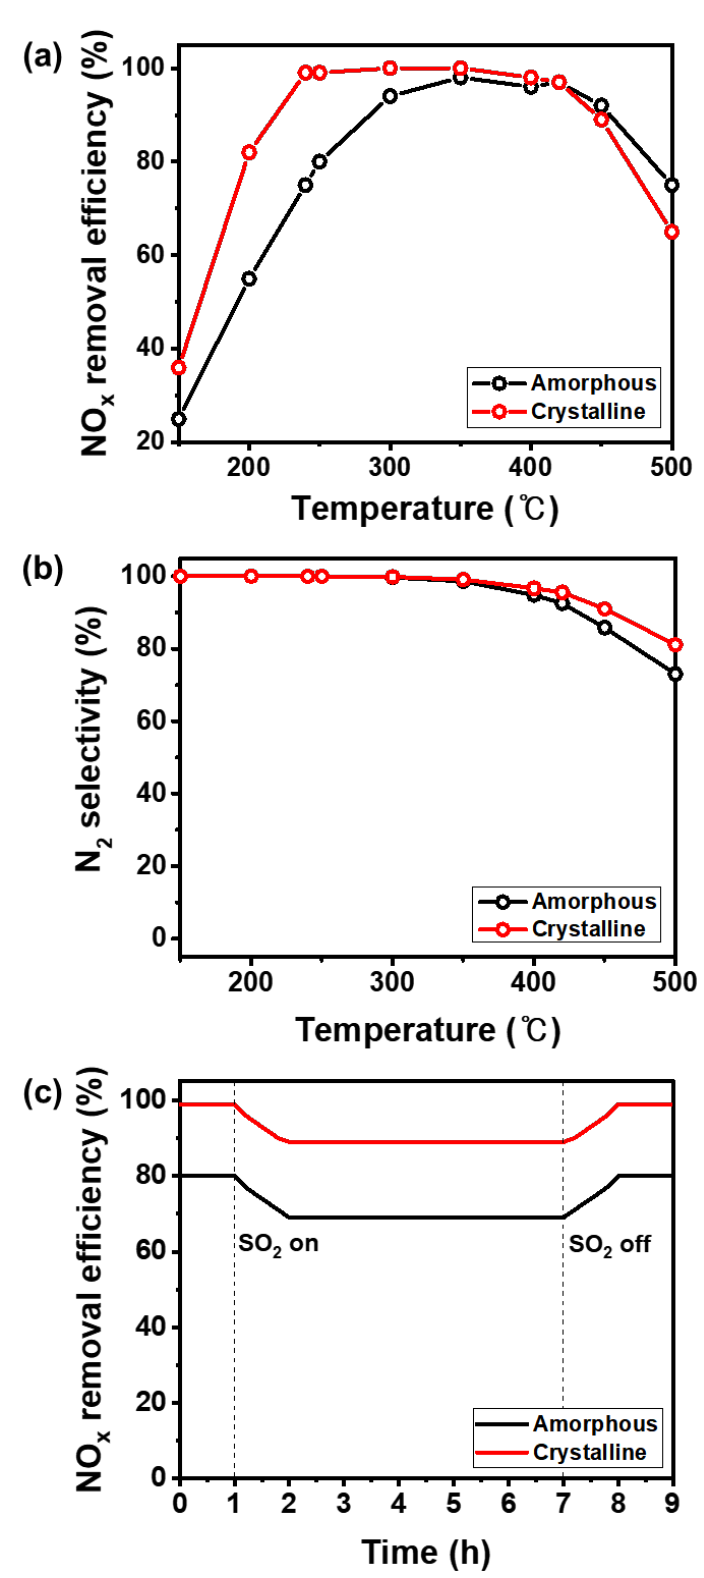
Figure 4. ( a ) NOx removal efficiency; ( b ) N 2 selectivity of the V 2 O 5 -WO 3 /TiO 2 catalysts and ( c ) SO 2 tolerance of the V 2 O 5 -WO 3 /TiO 2 catalysts with different crystal structures at 250 °C (black and red lines represent the amorphous and crystalline V 2 O 5 -WO 3 /TiO 2 , respectively). Reaction conditions: [NO] & [NH 3 ] = 300 ppm, [O 2 ] = 5 vol.%, [GHSV] = 60,000 h −1 .